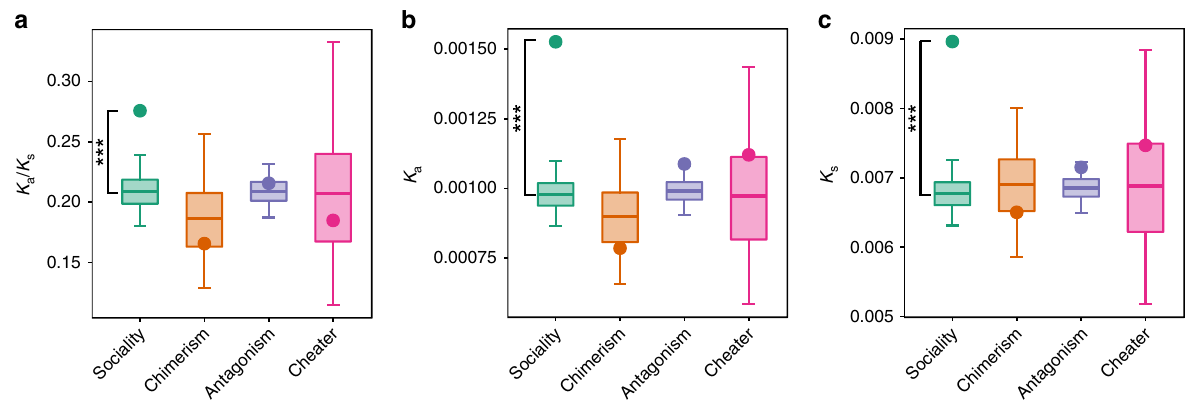
Fig. 3 Evolutionary rates at social genes. Given is the evolutionary rates a , and rates of substitution at nonsynonymous ( K a ) b and synonymous ( K s ) sites c . Substitutions represent changes compared with the sequence of a divergent strain, OT3A, from Mexico. Average estimates for each group of genes (points) were compared with randomization distributions (boxplots). The middle line, bottom, and top of the box show the expected mean, 25th and 75th percentiles, respectively; whiskers present the 95% con fi dence interval of the distributions. Randomization distributions were generated for each group of social genes by generating a set of 10,000 random groups of genes of size N (where N corresponds to the number of genes in the particular group of social genes being tested). Randomization was done separately for each group of social genes by sampling from a set that contains that group of social genes and its corresponding background set of genes. Two-tailed p values are de fi ned as the probability of obtaining a mean as extreme as the observed only owing to chance. Signi fi cance after FDR correction: p < 0.05 *; p < 0.01 **; p < 0.001 ***. Source data are provided as a Source Data fi